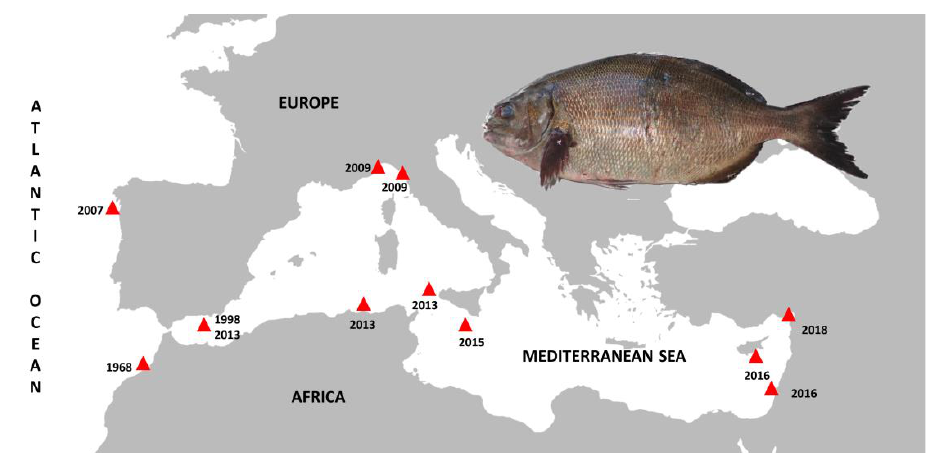
Figure 3. Distribution map of Kyphosus vaigiensis showing the chronology of detection from subtropical to temperate Atlantic and Mediterranean Sea.